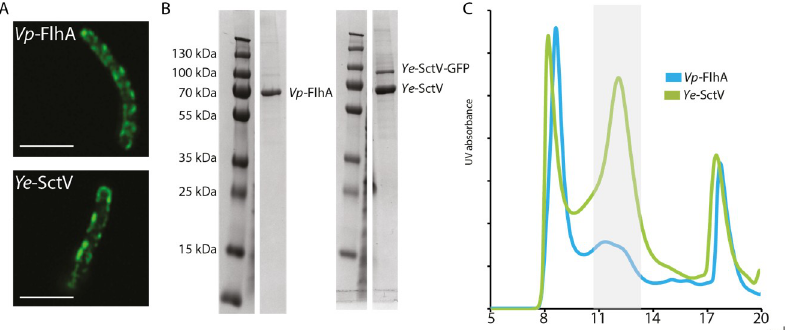
Fig 1. FlhA from Vibrio parahaemolyticus and SctV from Yersinia enterocolitica assemble into a large complex in the membrane of E . coli . a. Fluorescence images of E . coli cells expressing GFP tagged Vp -FlhA or Ye -SctV in the cell envelope. Scale bar 5 μ m. b. SDS-PAGE of purified Vp -FlhA and Ye -SctV following cleavage of GFP. c. Gel filtration traces of purified Vp -FlhA and Ye -SctV. The grey shaded area indicates fractions collected to make cryoEM